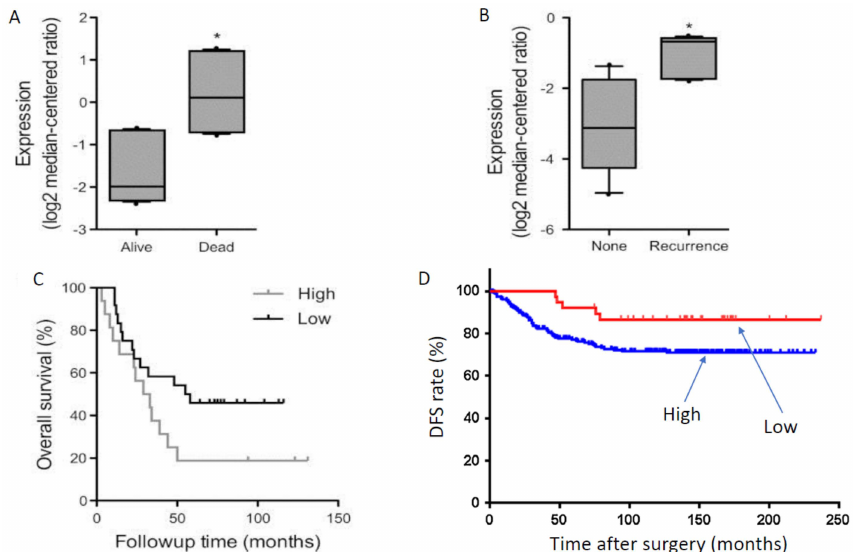
Figure 2. Positive associations between VGSC (Nav1.5) expression and clinical behaviour of breast and colon cancers. The channel is presumed to be ‘neonatal’ Nav1.5. ( A ) Patients who died of breast cancer expressed significantly more Nav1.5 mRNA than those who were alive. * = p < 0.05. ( B ) Breast cancer patients whose cancer recurred expressed significantly more Nav1.5 mRNA than those who were still cancer-free. * = p < 0.05. ( C ) Overall survival was significantly longer for breast cancer patients expressing low levels of Nav1.5 mRNA, compared with those with high levels of expression ( n = 181). ( D ) Disease-free survival (DFS) of colon cancer patients in relation to Nav1.5 protein expression ( n = 23 and 183 for low- and high-expression, respectively; p = 0.032). Time is for months after radical resection. Modified from [41] ( A – C ) and [42] ( D